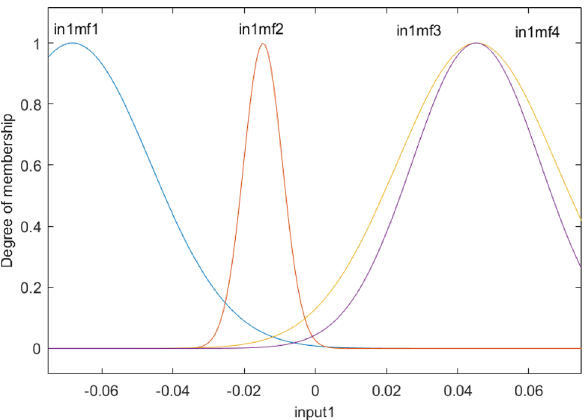
Figure 4. Degree of membership function, and the function performance as a function of the first input for four membership functions for each input parameter.